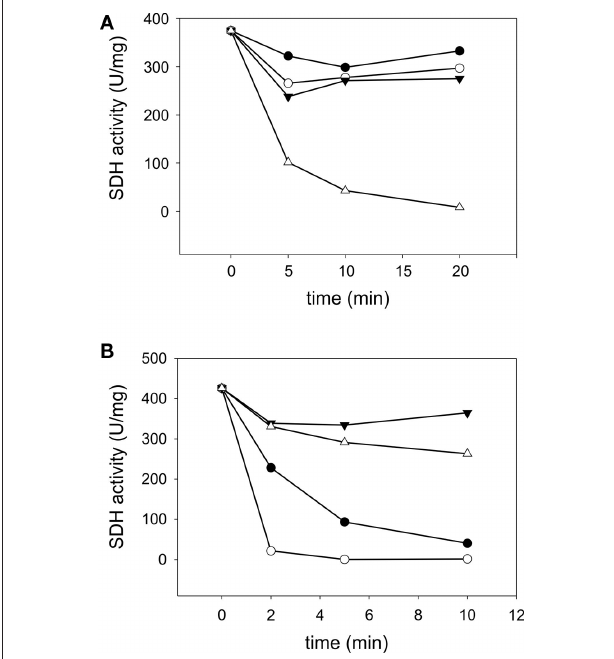
Figure 3 | Temperature stability of rSorT (A) changes in rSorT activity following incubation at 20 ° C ( l closed circles), 30 ° C ( ¡ open circles), 40 ° C (  closed triangles), and 50 ° C (  open triangles) for 5, 10, and 20 min. (B) rSorT inactivation at 50 ( l closed circles) and 60 ° C ( ¡ open circles) and protective effect of sulfite reduction on rSorT temperature stability at these temperatures. 50 ° C + sulfite (  closed triangles) and 60 ° C + sulfite (  open triangles).